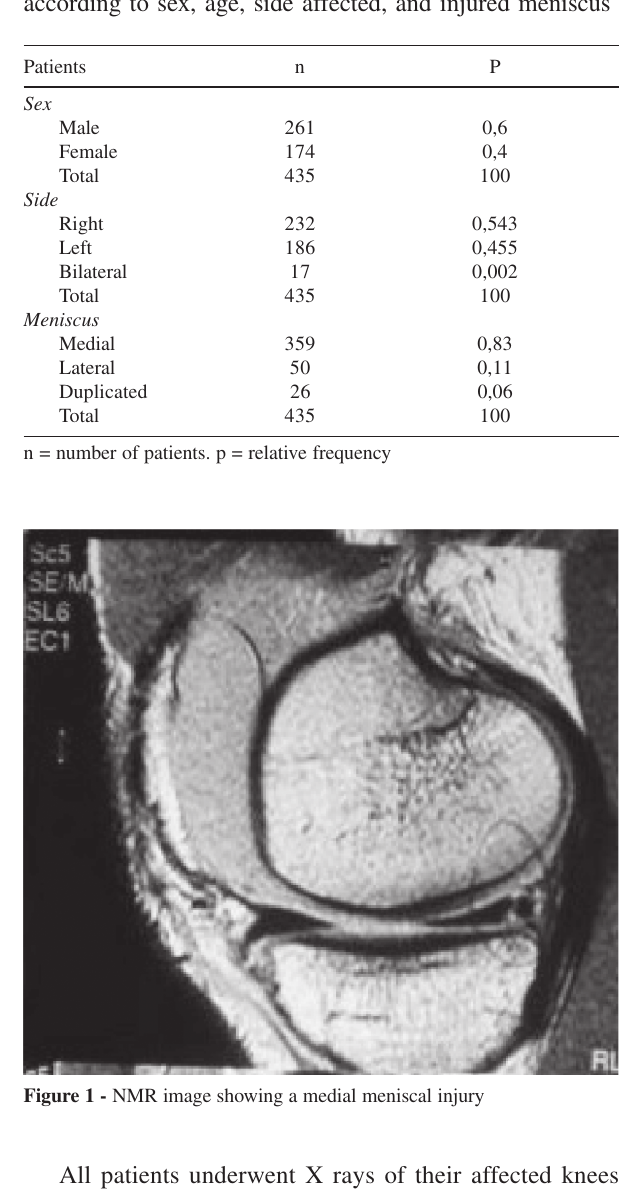
I - Traumatic injury group, formed by 194 patients with II - Degenerative injury group, formed by 101 patients